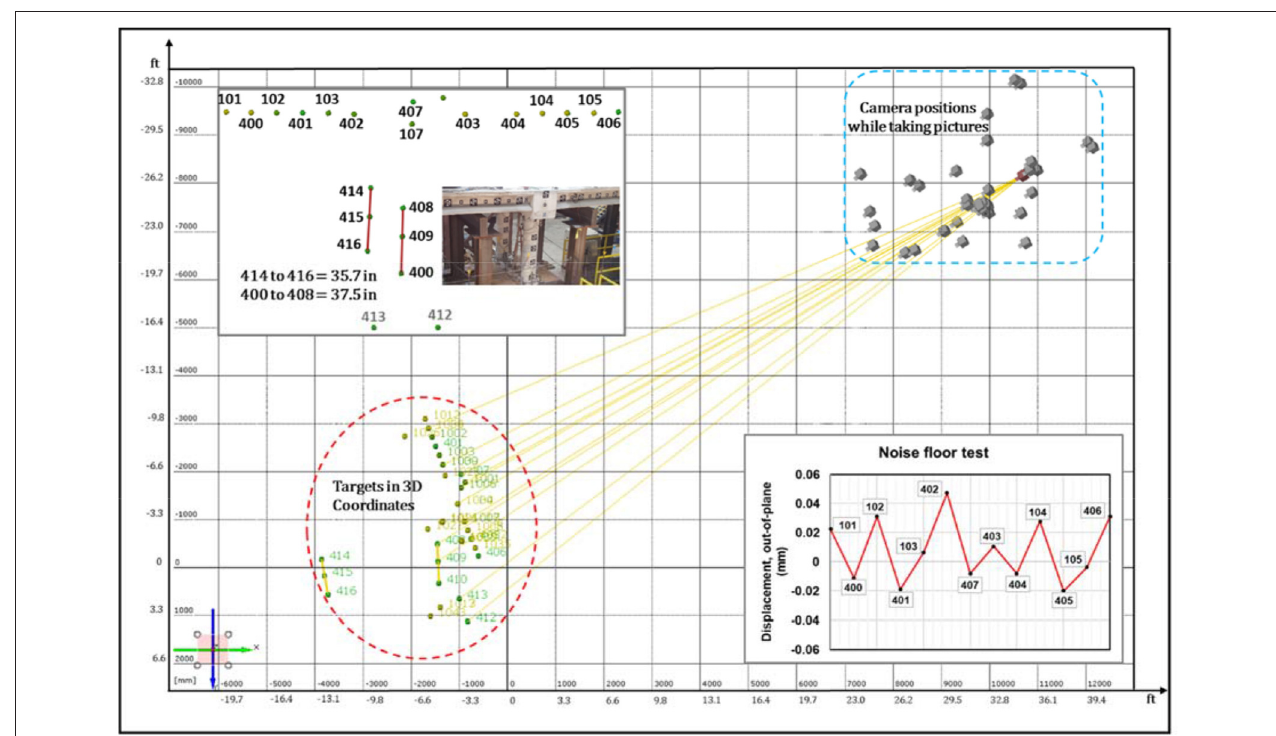
FIGURE 3 | Calibration results of Bridge#1 showing targets in 3D coordinates, camera position while taking calibration pictures, and the image rays from left camera reaching all targets; the result of noise floor test of targets on